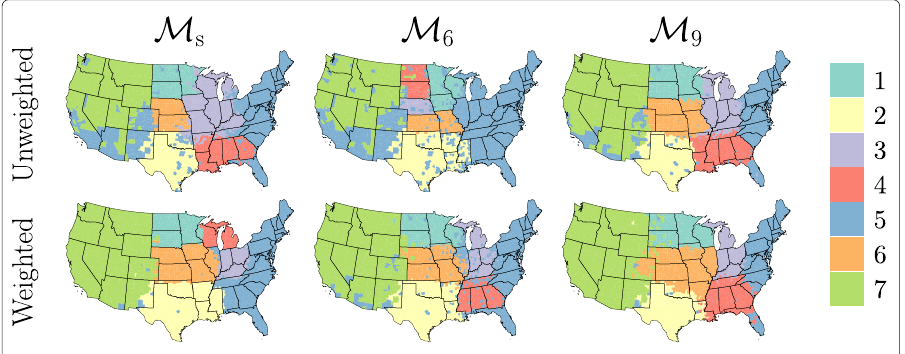
Fig. 10 Motif-based clusterings of the US-M IGRATION network, for various functional motifs. Each county (node) is colored by its cluster allocation. Top row : clusterings from the unweighted graph. Bottom row : clusterings from the weighted graph. M s corresponds to using the symmetrized adjacency